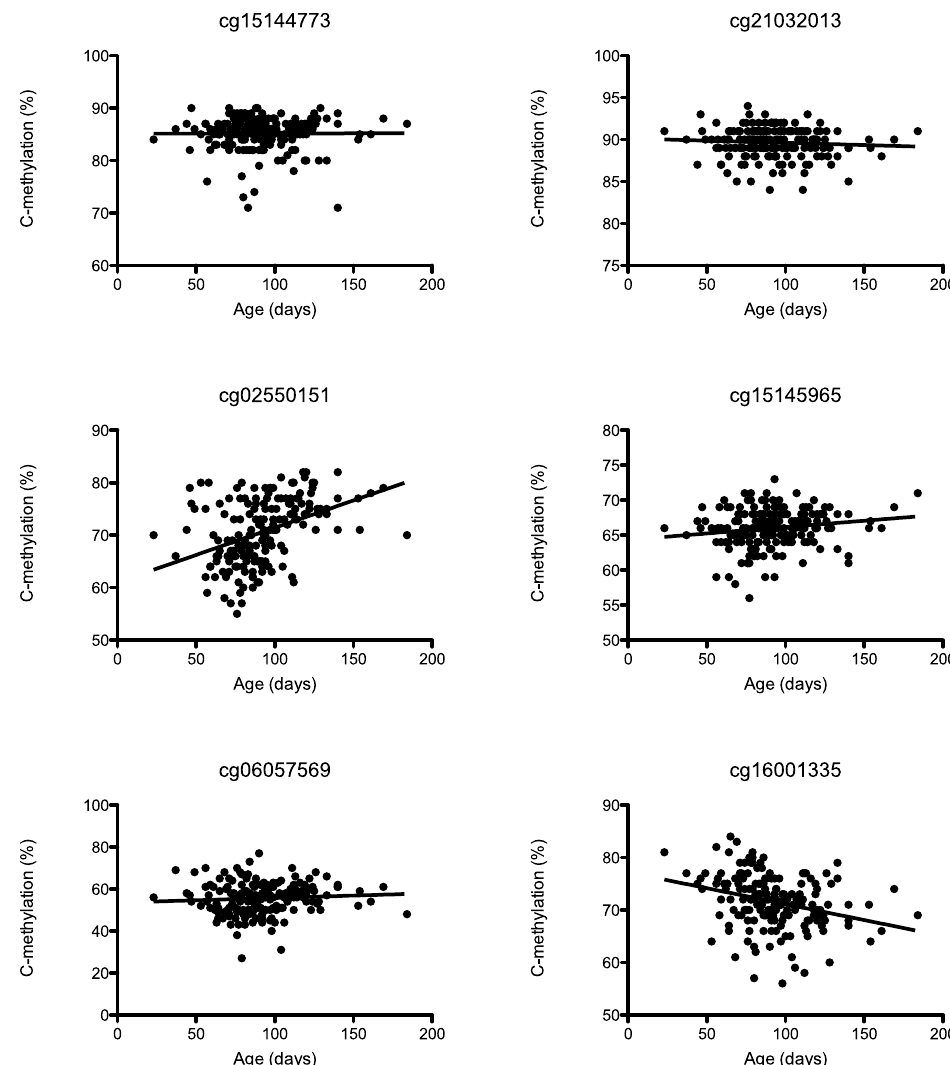
Fig 4. Methylation proportion changes in the BRD1 locus during fetal neocortex development. Methylationproportions in the BRD1 locus duringfetal neocortexdevelopment. A public available dataset was utilizedto correlate DNA methylationproportions with fetal age (n = 179, range = 23–184days post- conception). DNA methylation data was availablefor probes from the IlluminaInfinium Human Methylation 450K Bead Array. Probes located near the promoterregionof BRD1 were assessedfor correlationbetween DNA methylation proportionsand fetal age. All probesthat revealedage related changesin methylation proportions and some that did not are illustrated. Statistical analysiswas performed with Pearson’scorrelation